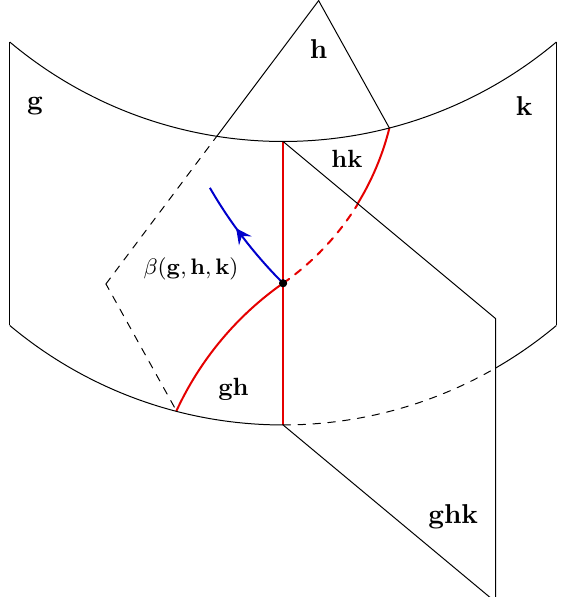
Figure 3 . A transformation of symmetry defects can be used to detect 2-group global symmetry. The lines (labelled g ; h ; k ; ghk ) are codimension-1 symmetry operators of G . Transforming from left to right (also called an F -move), a 1-form symmetry defect (cid:12) ( g ; h ; k ) 2 A is created (blue dot). In d dimensions, all objects span the remaining d (cid:0) 2 dimensions. A probe line passing through the 0-form symmetry defects, detects [ (cid:12) ] and hence sees the non-associativity of the 0-form symmetry defects.